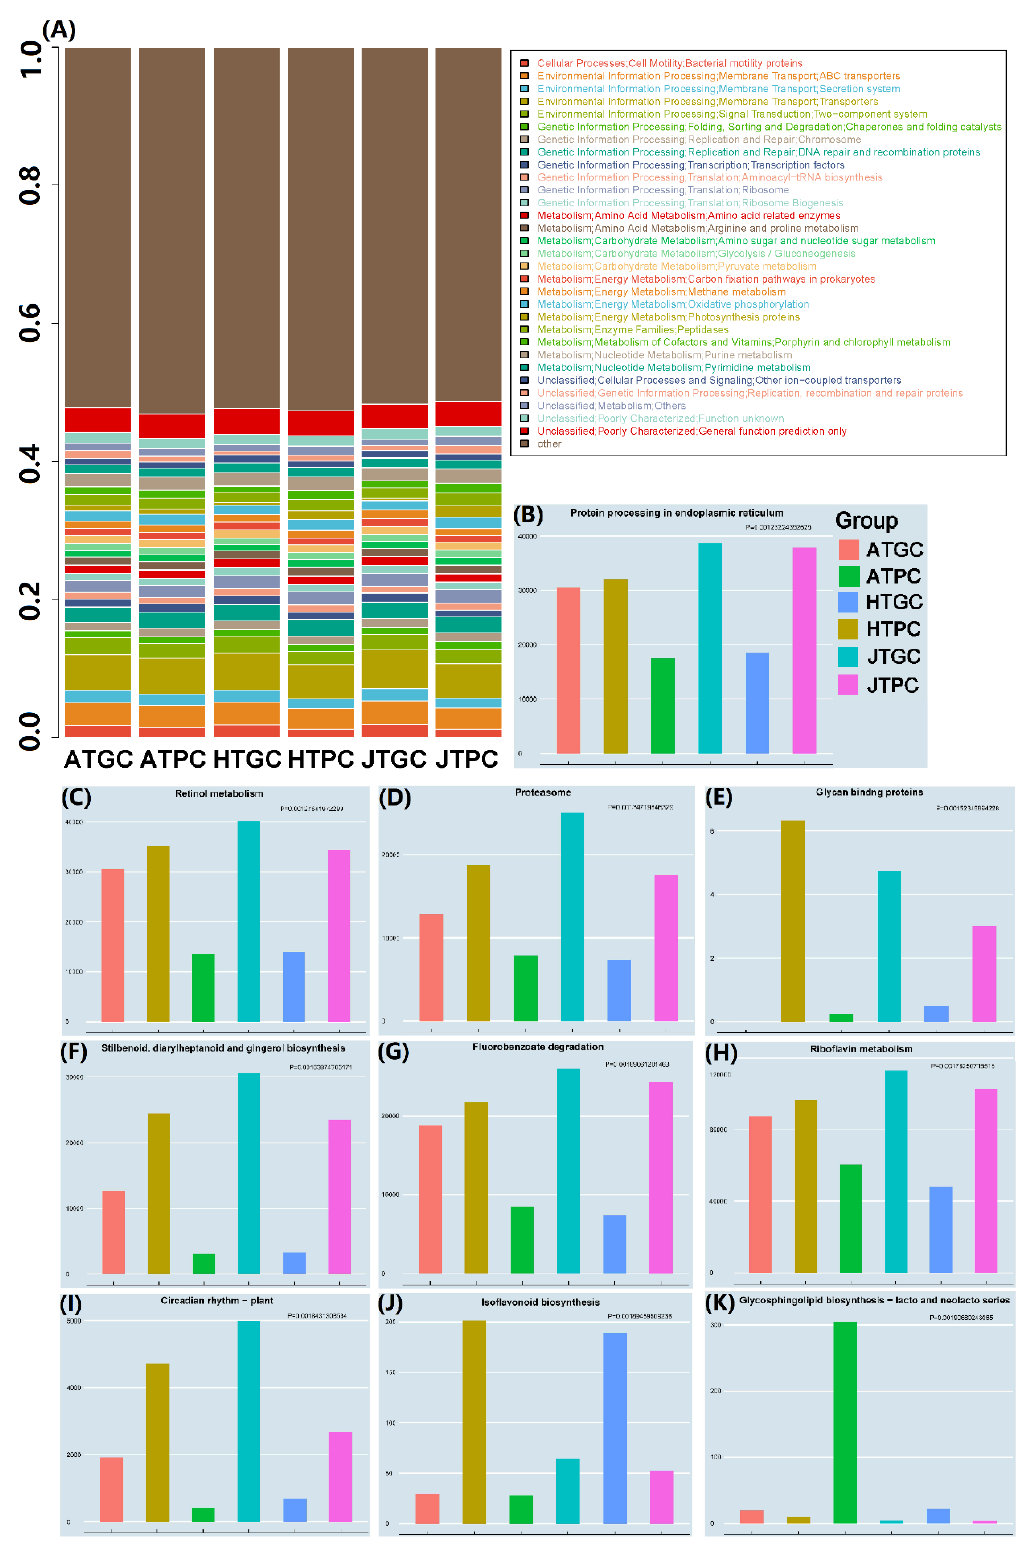
Figure 4. Gene function prediction (top30) ( A ) and top10 in gene function predictive expression p value ( B – K ) of all six groups based on the COG database.